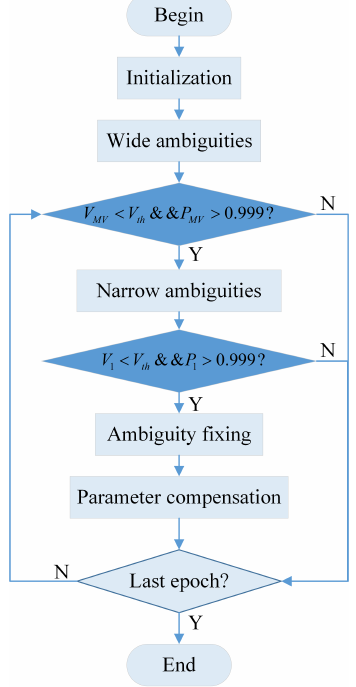
Figure 4. The flow chart of ambiguity fixing